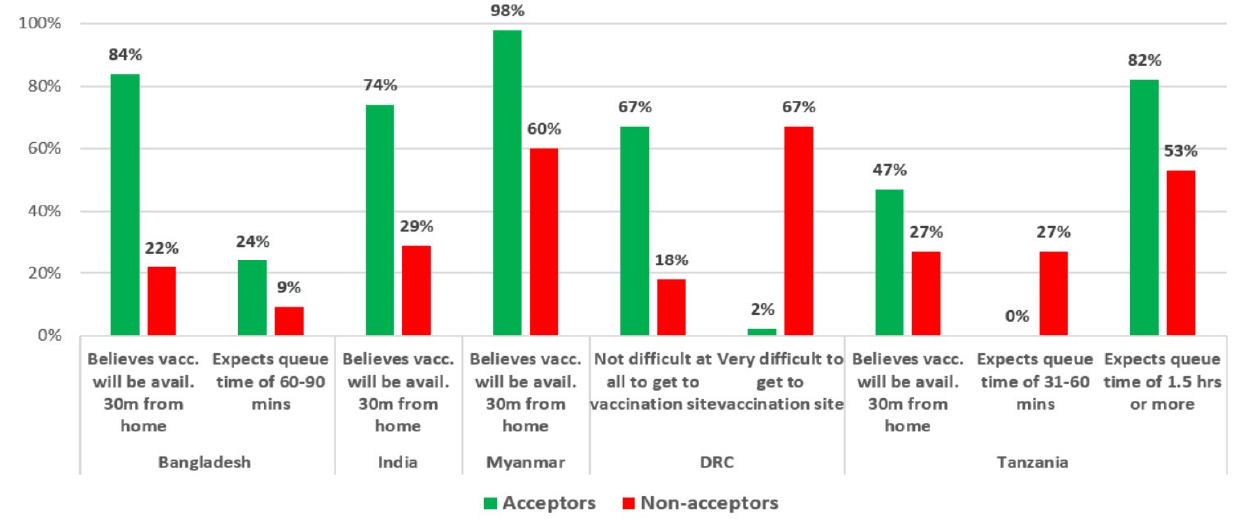
Figure 9. Perceived access to COVID-19 vaccines by country.